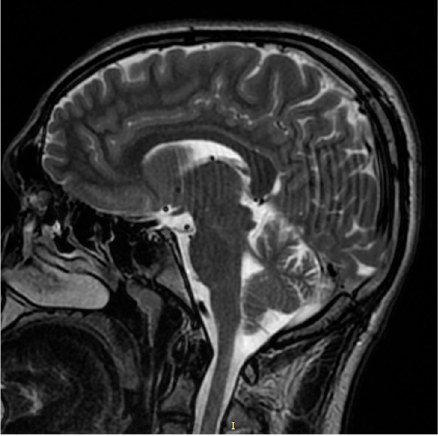
Figure 8. Brain MRI—Sagittal T2-weighted section. Normal brain imaging.